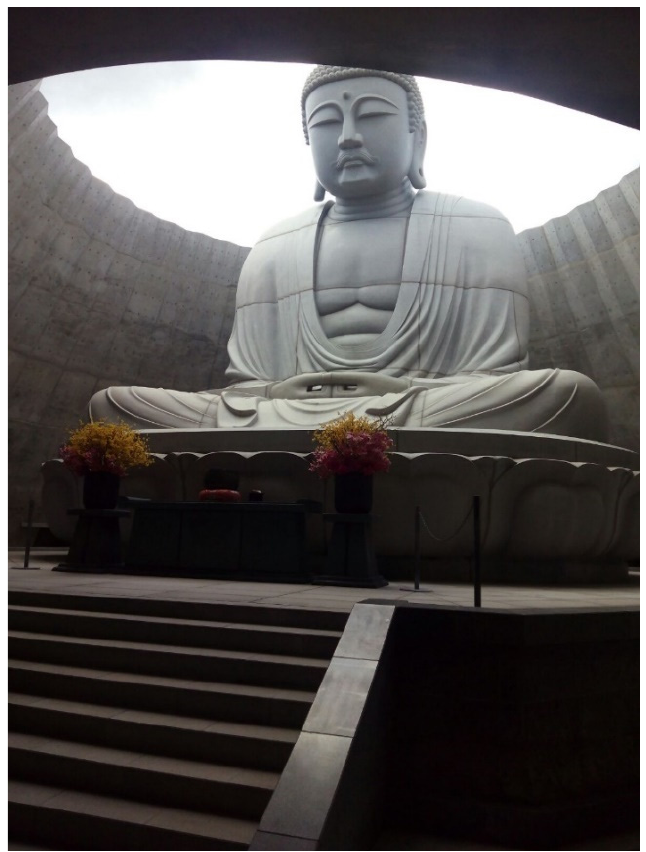
Figure 31. Tadao Ando’s Buddha Hill at Makomanai Takino Cemetery (Sapporo).